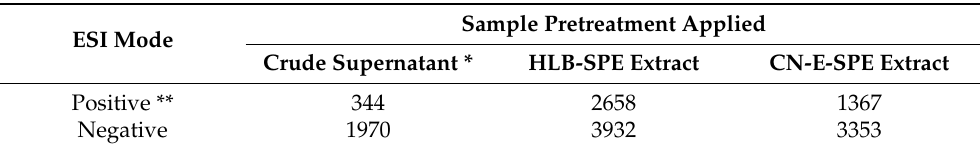
Table 2. Number of m / z features present in each data matrix after data processing and molecular formula